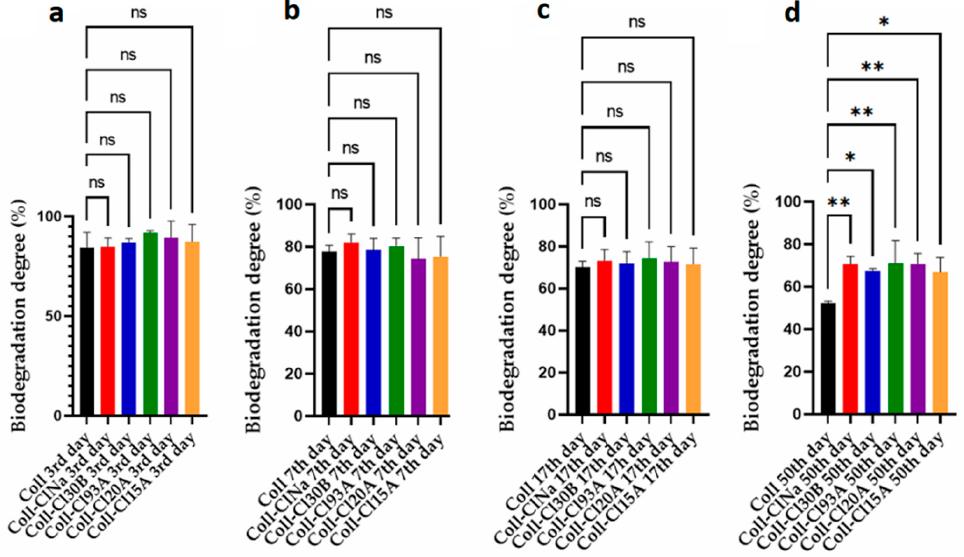
Figure 6. Biodegradation degree as function of time for the composite samples: ( a ). third day; ( b ). 7th day, ( c ).17th day; ( d ). 50th day (ns p > 0.05, * p ≤ 0.05, ** p ≤ 0.01).